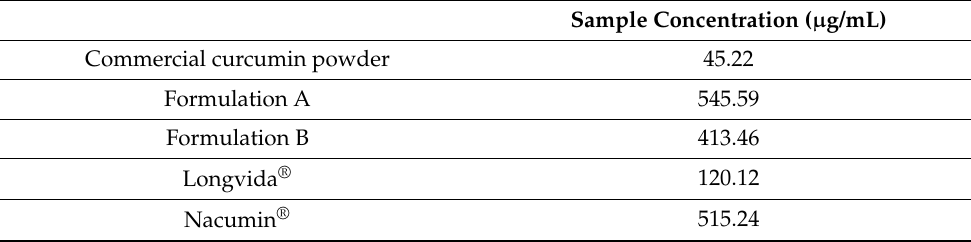
Table 4. The concentration of each test sample needed to prepare a donor suspension containing 0.1